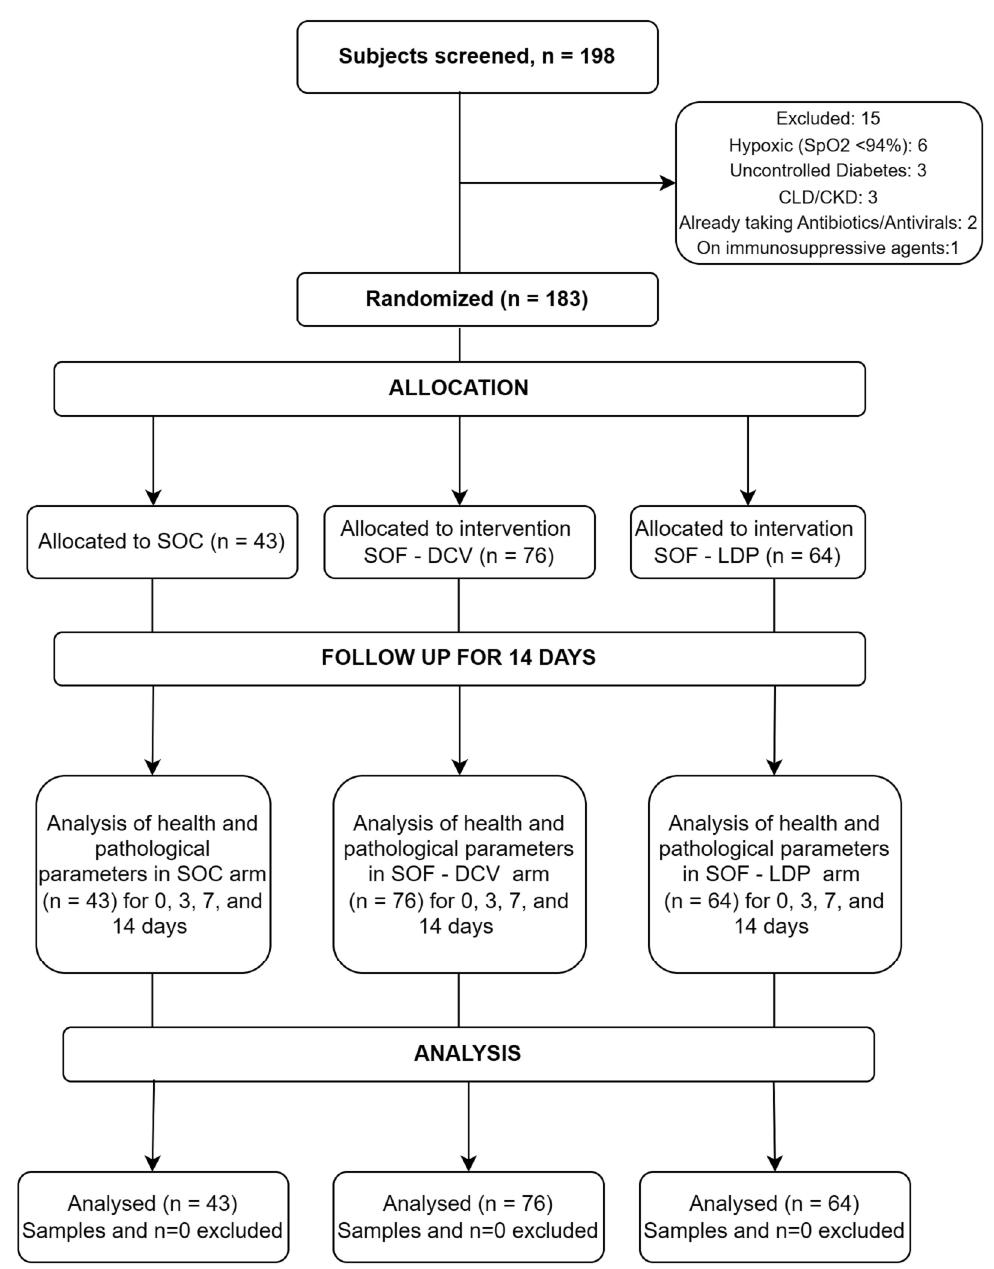
Figure 3. CONSORT Flowchart diagram for patient enrollment, randomization and follow-up. DCV: daclatasvir; LDP: Ledipasvir; SOC: standard of care; SOF, sofosbuvir: SpO 2 : Oxygen saturation as per pulse oximetry; CLD: Chronic liver disease; CKD: Chronic Kidney Table 2. Baseline clinical and laboratory features of the study participants.